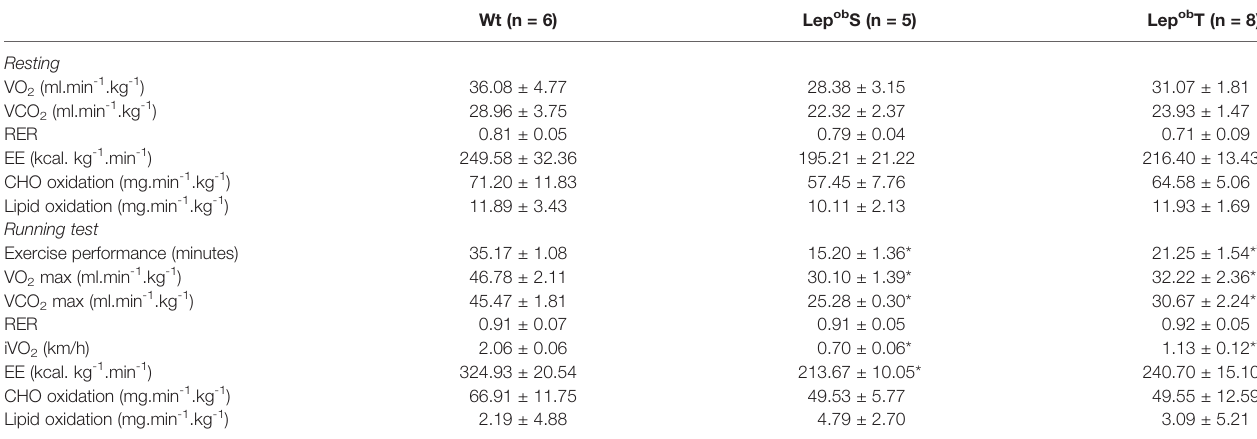
TABLE 2 | Metabolic response at rest and at maximal running test.